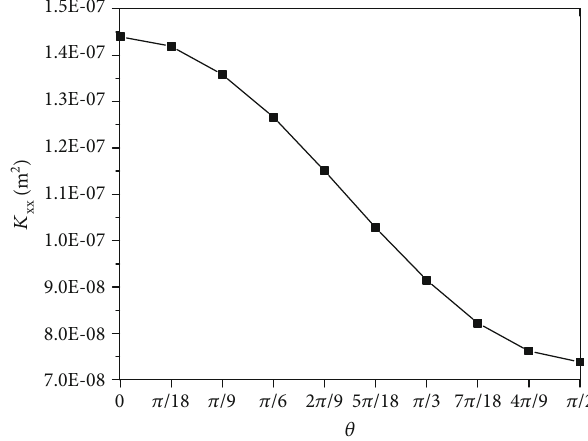
Figure 9: The relationship between K β = 0 : 01 , and α = π /4 ).